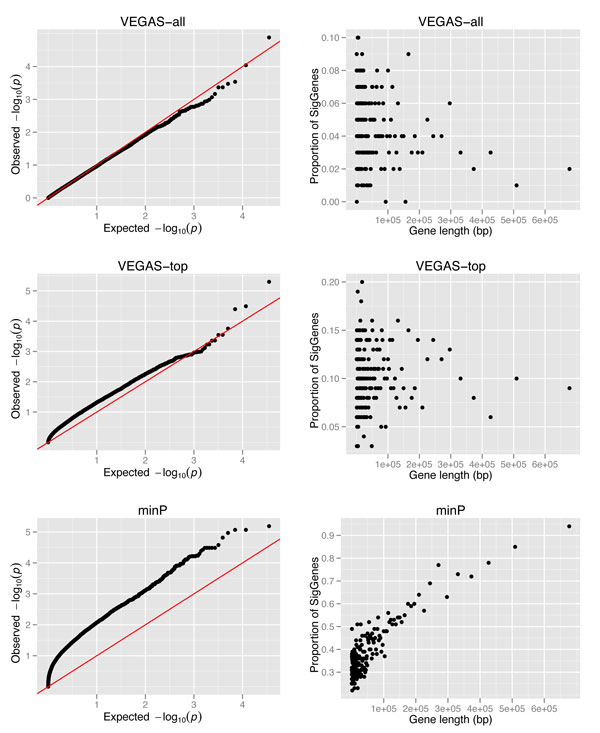
Q-Q plot of gene-wise P values and their distribution versus gene length. The three rows of panels represent the method of VEGAS-all, VEGAS-top, and minP, respectively. In each row (method), the left panel displays the Q-Q plot, while the right panel shows the distribution of gene-wise P values versus gene length. In the right panel, gene length (X-axis) was separated to bins, each of which has 100 genes; the Y-axis shows the proportion of significant genes (denoted as "SigGenes") in each length bin. SigGenes were defined as those with gene-wise P values <0.05.